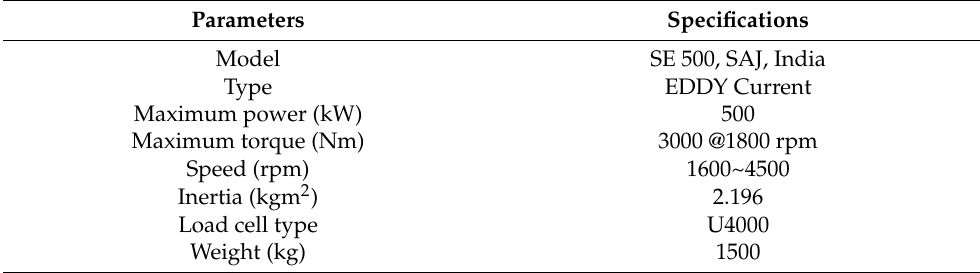
Table 2. The specifications of the dynamometer used in this